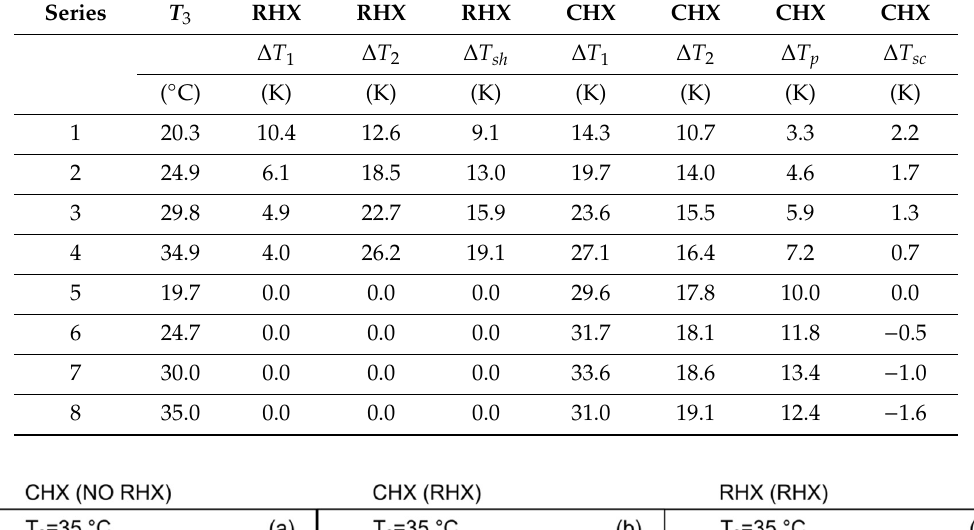
Table 2. Summary of temperature differences across the IHXs.